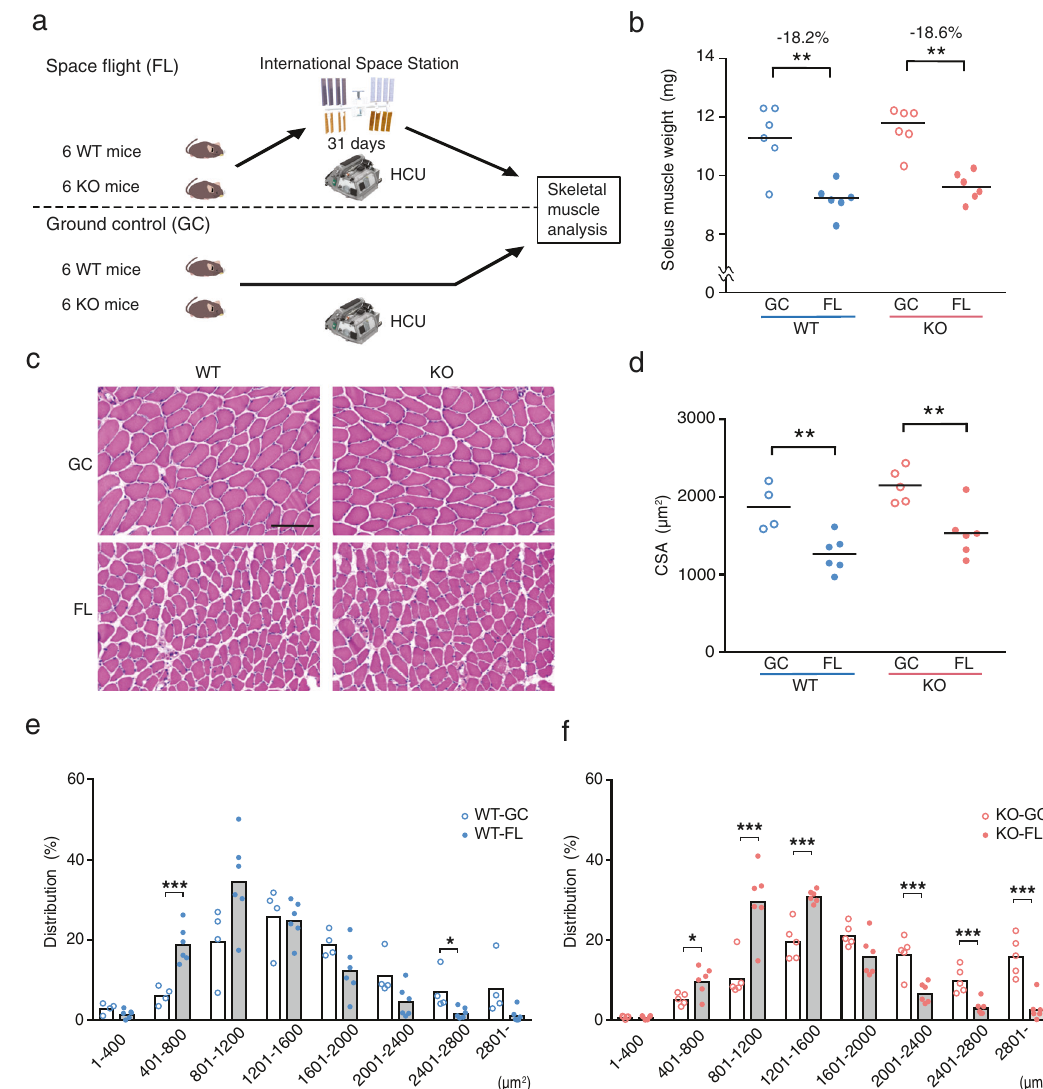
Fig. 1 Impact of Nrf2 de fi ciency on the soleus muscles of mice in a space experiment. a Overview of the space experiment (MHU-3 mission). Six WT and six KO mice were launched in the Japanese Experiment Module ‘ KIBO ’ on the ISS by SpX14 from the Kennedy Space Center in Florida. They were housed in ‘ KIBO ’ for 31 days and were then returned to Earth. b Absolute soleus muscle weights from WT-GC ( n = 6), WT-FL ( n = 6), KO-GC ( n = 6) and KO-FL ( n = 6) mice. c Haematoxylin – eosin staining of soleus muscle fi bre sections. Scale bar = 100 μ m. d CSA of each fi bre type in WT-GC ( n = 6), WT-FL ( n = 4), KO-GC ( n = 5) and KO-FL ( n = 6) soleus muscles. e Fibre area frequency distribution in WT-GC vs. WT-FL. f Fibre area frequency distribution in KO- GC vs. KO-FL. P values calculated using Student ’ s t test are indicated as follows: * P < 0.05, ** P < 0.01, *** P < 0.001, GC vs.